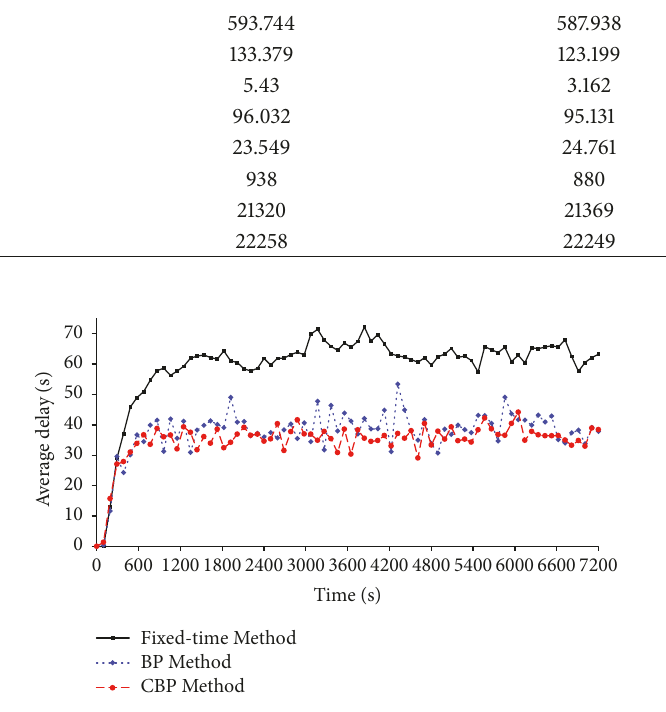
Figure 9: Average vehicle delay during